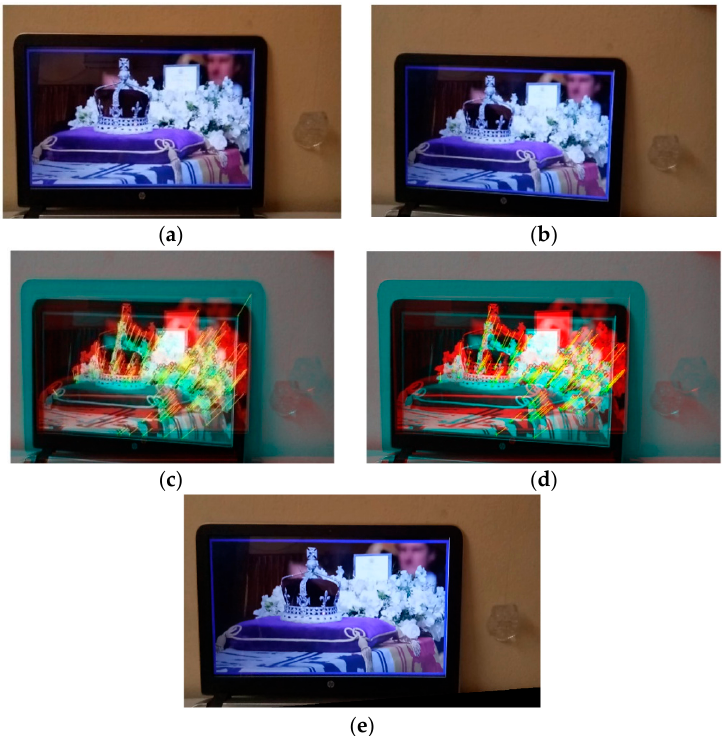
Figure 13. ( a ) Reference Image, ( b ) Captured Image, ( c ) Matched Features, ( d ) Valid Features, ( e ) Restored Image.